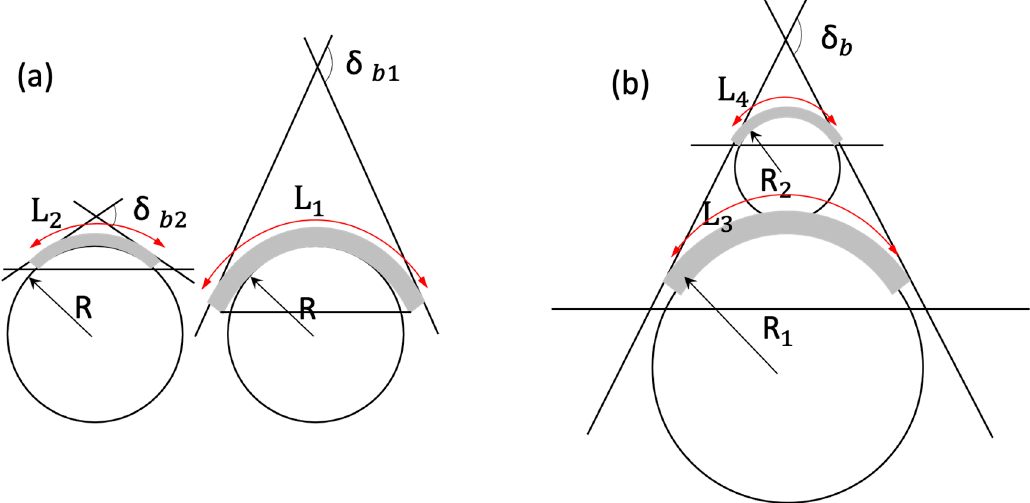
Figure 8. ( a ) The same curvature but different sensor length (shaded area) provides different bend angles; ( b ) different sensor lengths and different curvatures provide the same bend